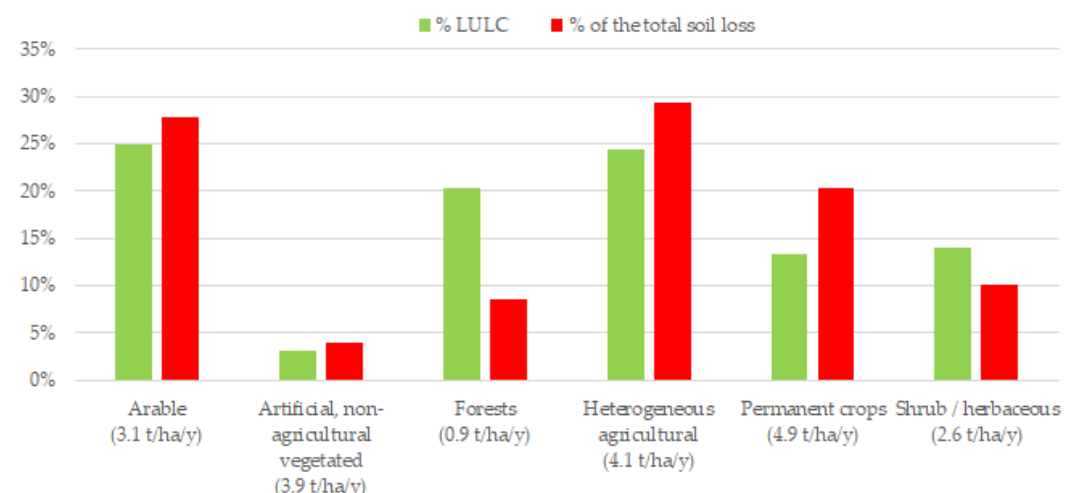
Figure 4. Mean soil loss rates per LULC and corresponding total soil loss.